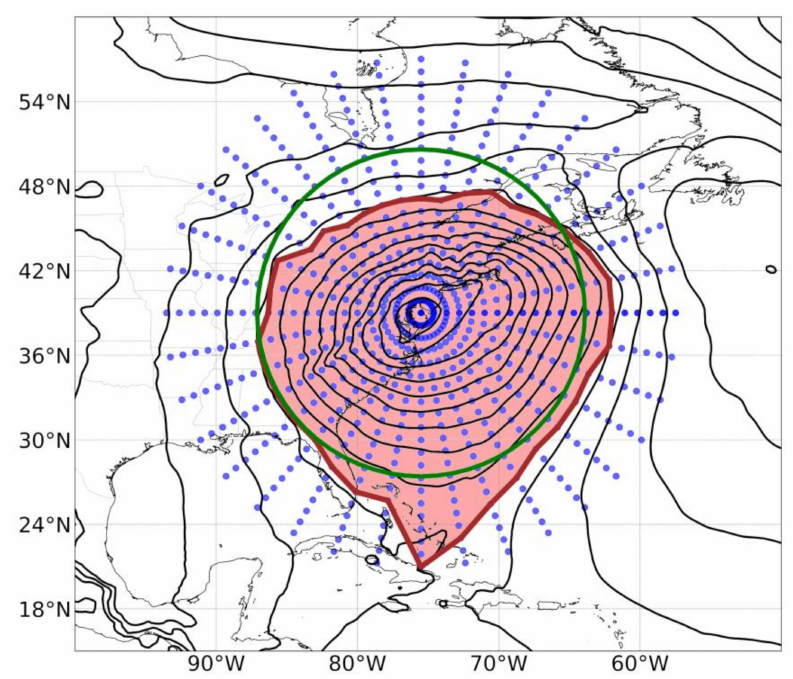
Figure 1. Representation of the outer radius estimates. The black lines represent the isobars, the blue dots denote the radial legs, the brown line represents the geometry of the low (the last closed isobar), the shaded area is the area delimited by the low geometry and the green line is the estimated outer